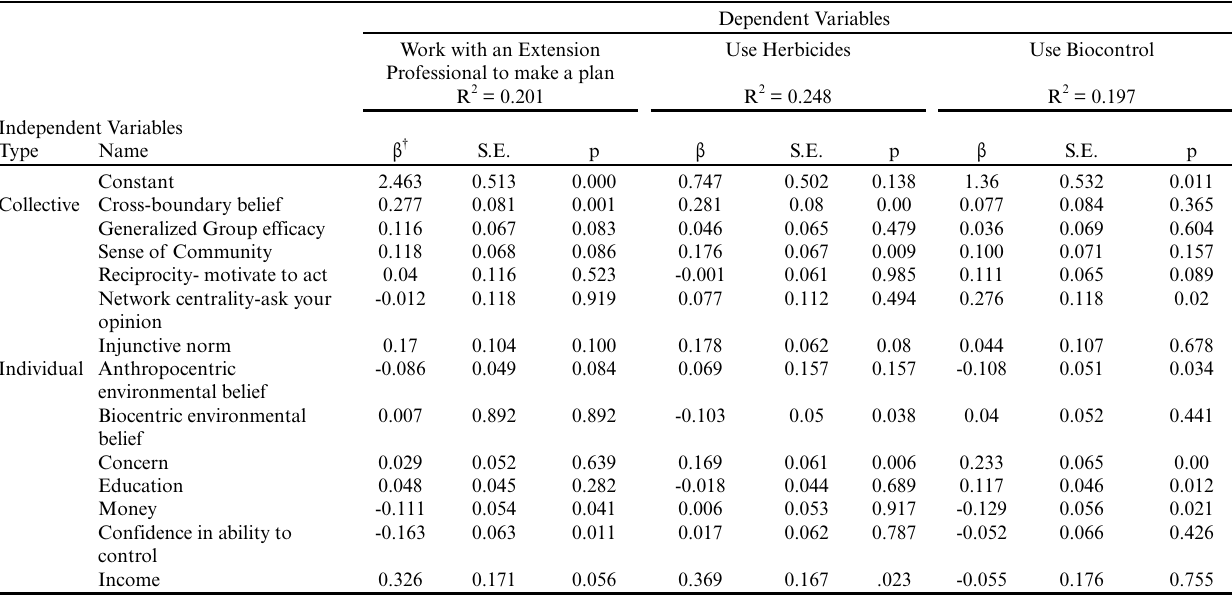
Table 2 . Selected independent variable from the collective interest model predicting willingness to engage in invasive species control behaviors, based on ordinary least squares (OLS) regression